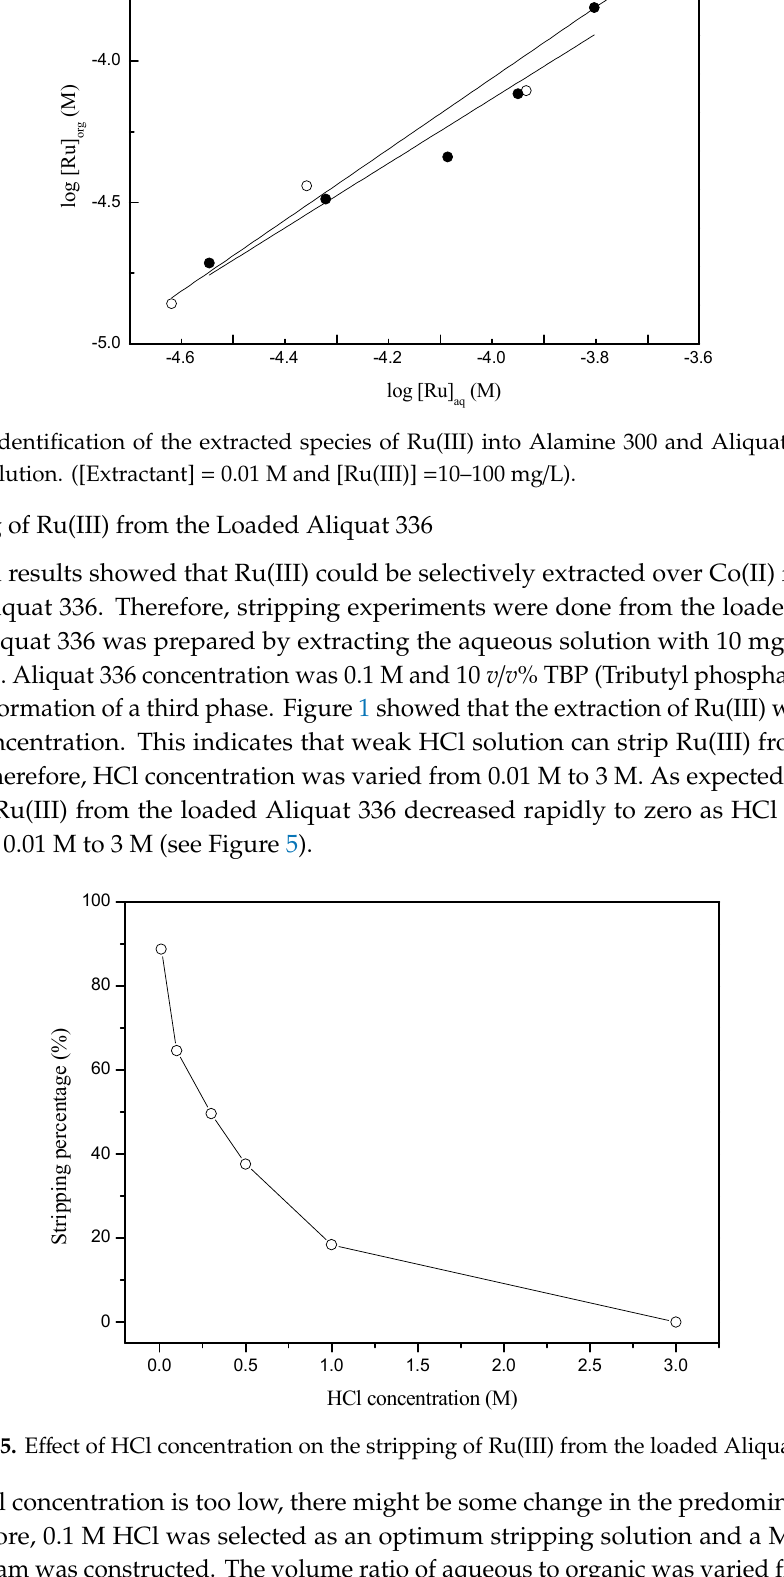
Figure 4. Identification of the extracted species of Ru(III) into Alamine 300 and Aliquat 336 from 3 M HCl solution. ([Extractant] = 0.01 M and [Ru(III)] =10–100 mg/L).